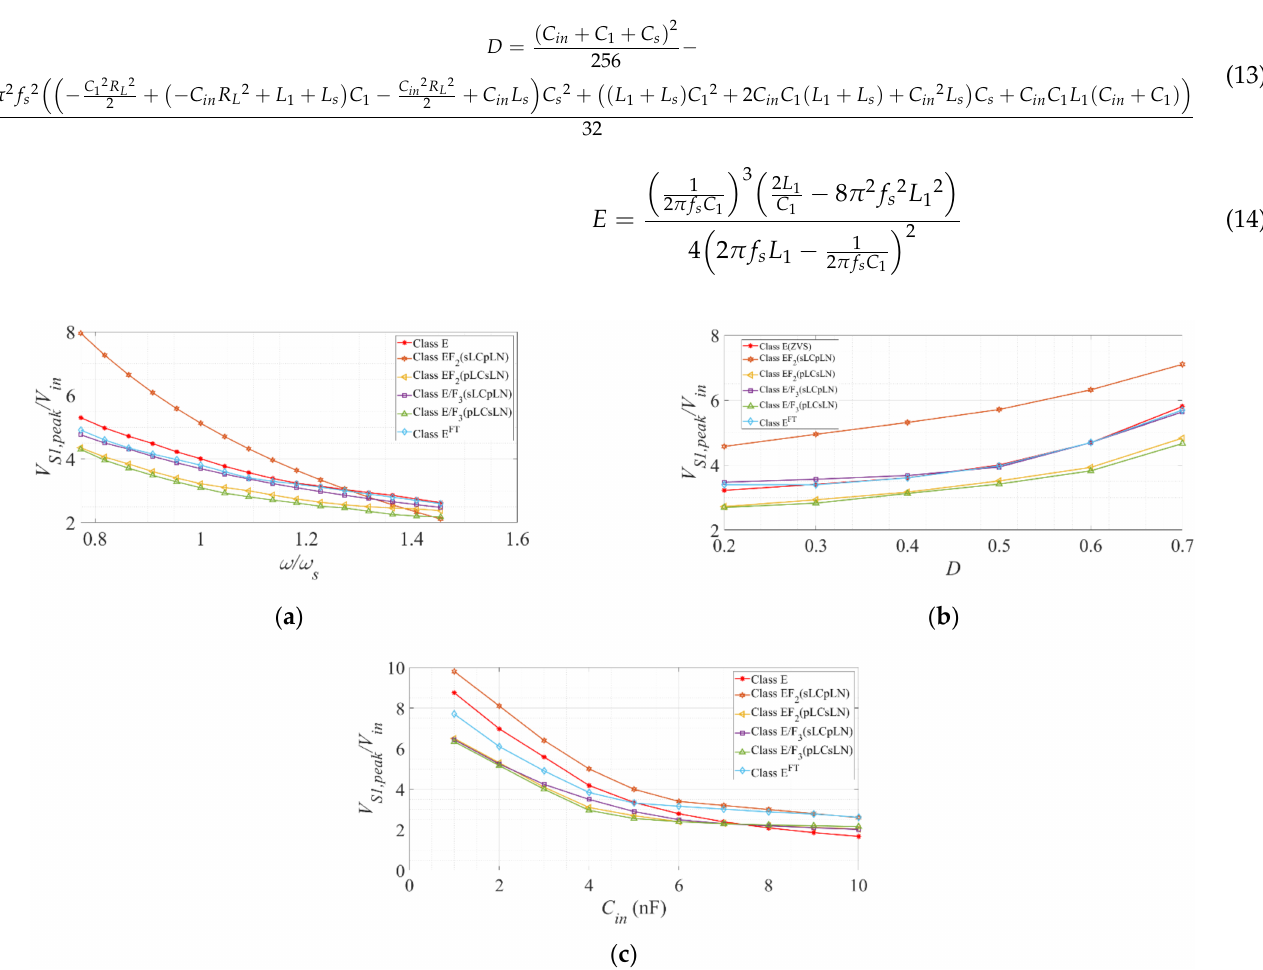
Figure 4. Peak switch voltage ( V S 1 ,peak ) of class E, EF 2 , and EF 3 against ( a ) normalized switching frequency ( ω / ω s ), ( b ) duty ratio ( D ), ( c ) the input capacitance ( C in ) at V in = 50 V, D opt = 0.50 (E) or 0.40 (EF 2 , E/F 3 ), f s ≈ 220 kHz, R L = R L,opt , k ≈ 0.30 (EF 2 ) and 0.67 (E/F 3 ).